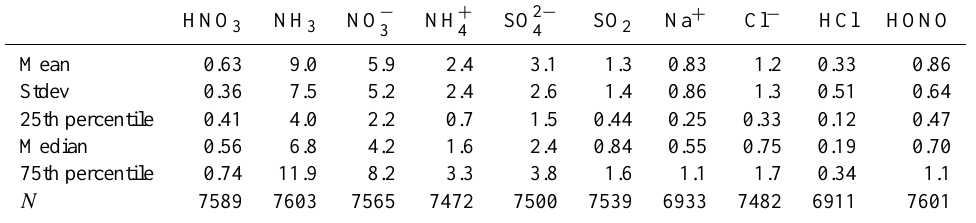
Table 1. Statistical summary of the measured concentrations between 1 August, 2007, and 1 August, 2008, at Cabauw. The mean, standard deviation as well as median and quartiles are presented. N indicated the number of (hourly) measurements. HNO